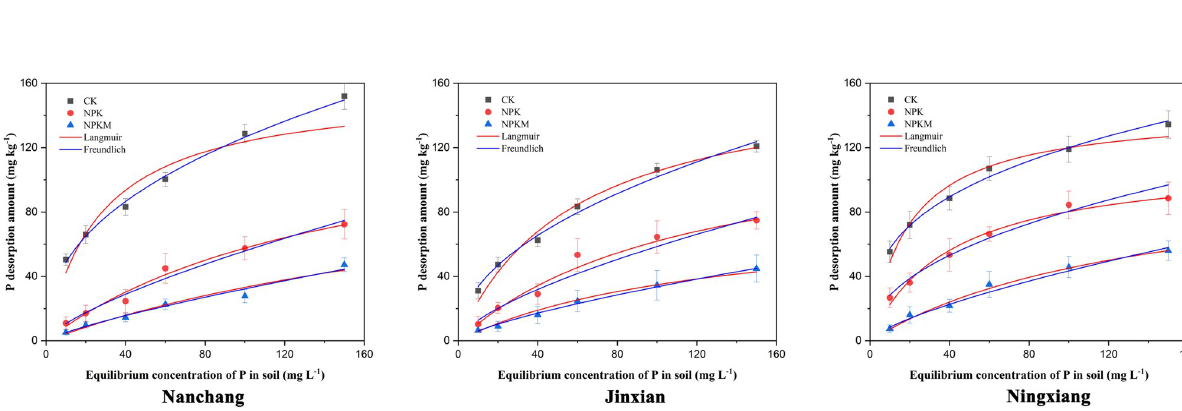
Fig 1. The adsorption isotherms of P in red paddy soils under three different long-term experimental sites.